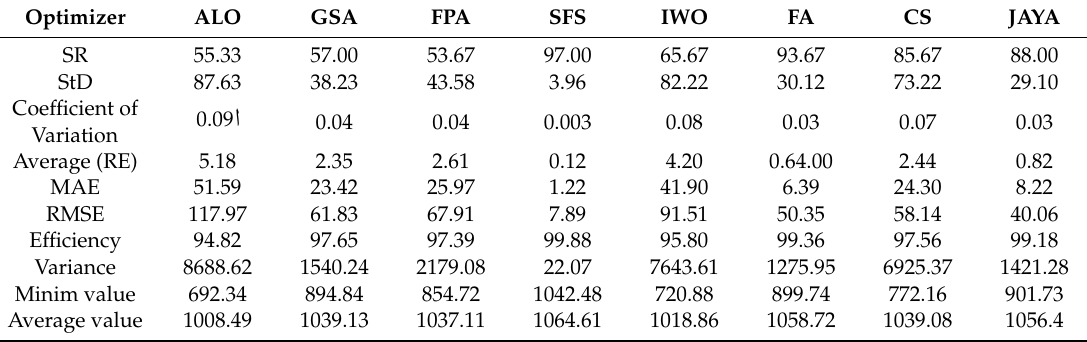
Figure 8. Performance comparison of different considered optimizers ( a ) success rate (SR); ( b ) standard deviation (StD); ( c ) coefficient of variation; ( d ) Average (RE); ( e ) RMSE and ( f ) Efficiency.